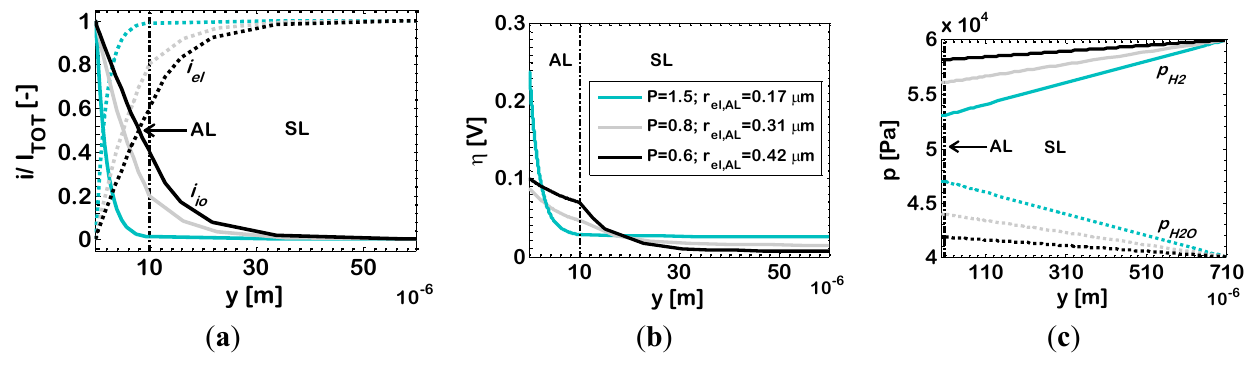
Figure 8. Bi-layered Ni-YSZ anodes at temperature T = 1073 K; Ni volumetric fraction in the AL ϕ = 0.44 (Case 2 ). Other data reported in Table 2. Varying parameter: AL Ni el,AL c particle radius r . Simulated distributions along the electrode thickness of: ( a ) ionic ( i el,AL and electronic ( i ) currents; ( b ) overpotential (η); and ( c ) partial pressures of hydrogen el ( p ) and water ( p ). H2 H2O